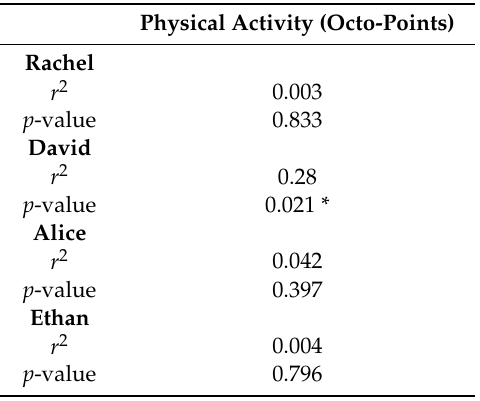
Table 4. N-of-1 analyses comparing baseline and intervention PA.